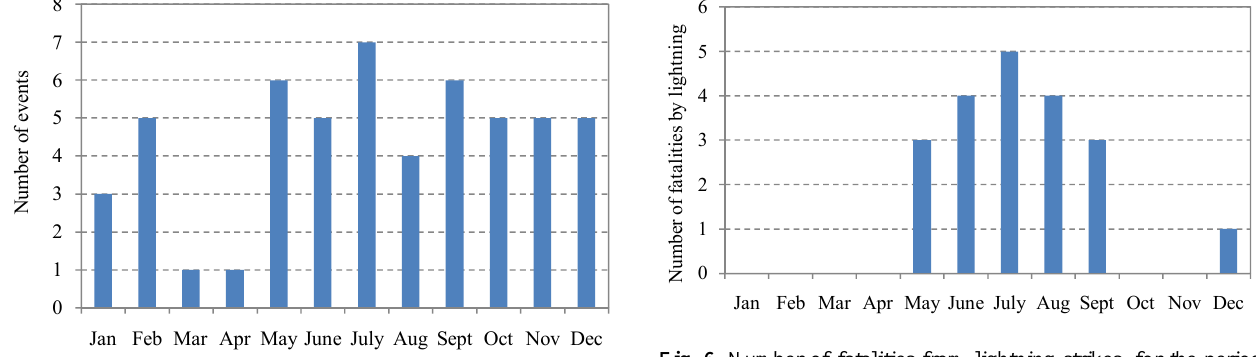
Fig. 4. Monthly distribution of weather events with human fatalities, for the period 2001–2011.